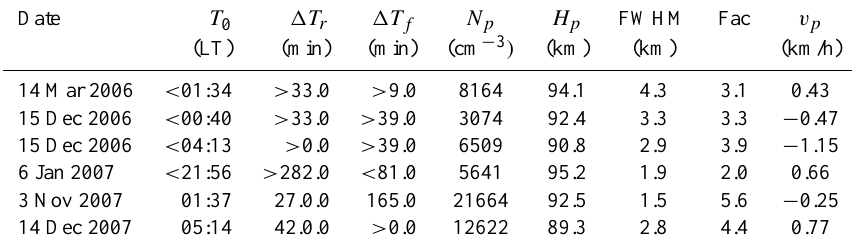
Table 4. Parameters of five co-observational SSL events observed at Wuhan by WIPM